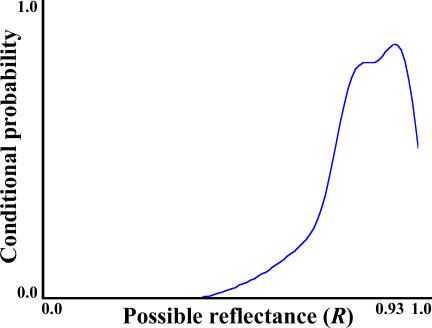
Conditional Probability Distribution of Reflectance Given Past Experience and a Particular Stimulus as ContextA maximum-likelihood estimation allows the observer to predict the target reflectance and will be correct (approximately) most of the time. If the true reflectance actually lies in a low-likelihood tail of the distribution, then the resulting percept is an illusion.